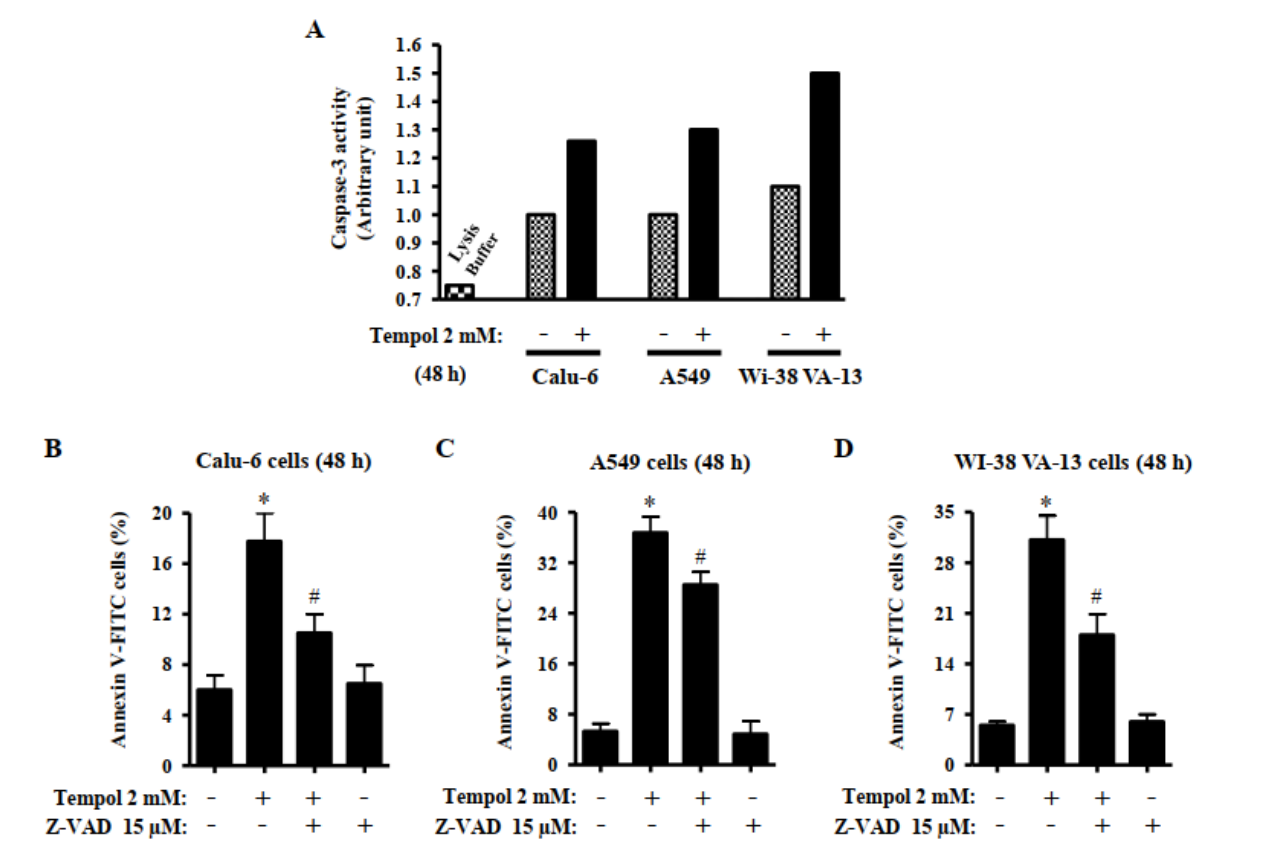
Figure 5. Effects of Tempol and/or Z-VAD on caspase-3 activity and cell death in Calu-6, A549, and WI-38 VA-13 cells. Exponentially growing cells were pretreated with Z-VAD for 1 h and then treated with 2 mM Tempol for 48 h. ( A ): Graph shows the activities of caspase-3 in Calu-6, A549, and Wi-38 VA-13 cells, measured via Colorimetric Assay. ( B – D ): Graphs show the proportion of annexin V-positive Calu-6 cells ( B ), A549 cells ( C ), and WI-38 VA-13 cells ( D ), measured with a FACStar flow cytometer. ANOVA test was used. * p < 0.05 compared to Tempol-untreated control cells. # p < 0.05 compared to cells treated with Tempol only.